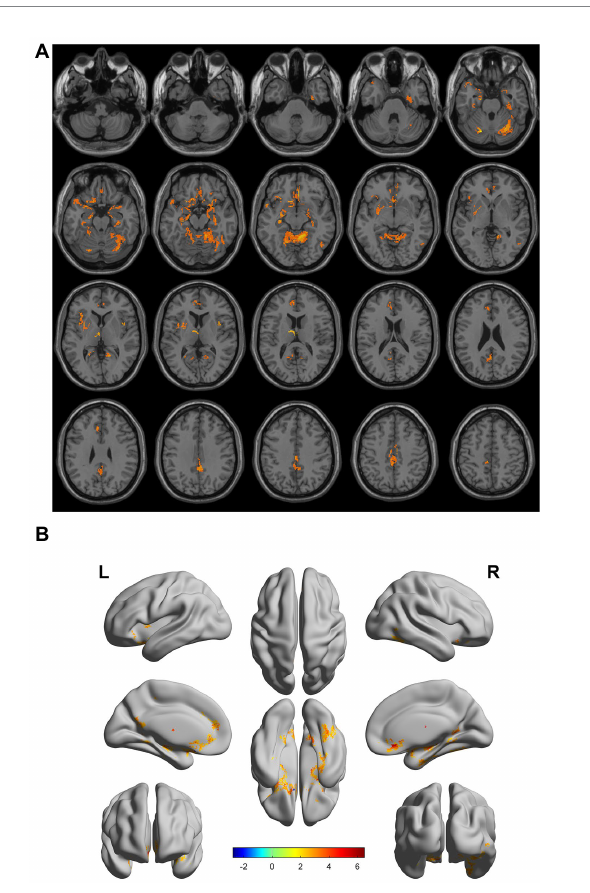
FIGURE 4 (A, B) Compared with the subcortical ischemic vascular disease (SIVD)- normal cognitive impairment group, the area distribution of gray matter atrophy was observed in the SIVD-vascular dementia group. Orange- yellow shows the areas of